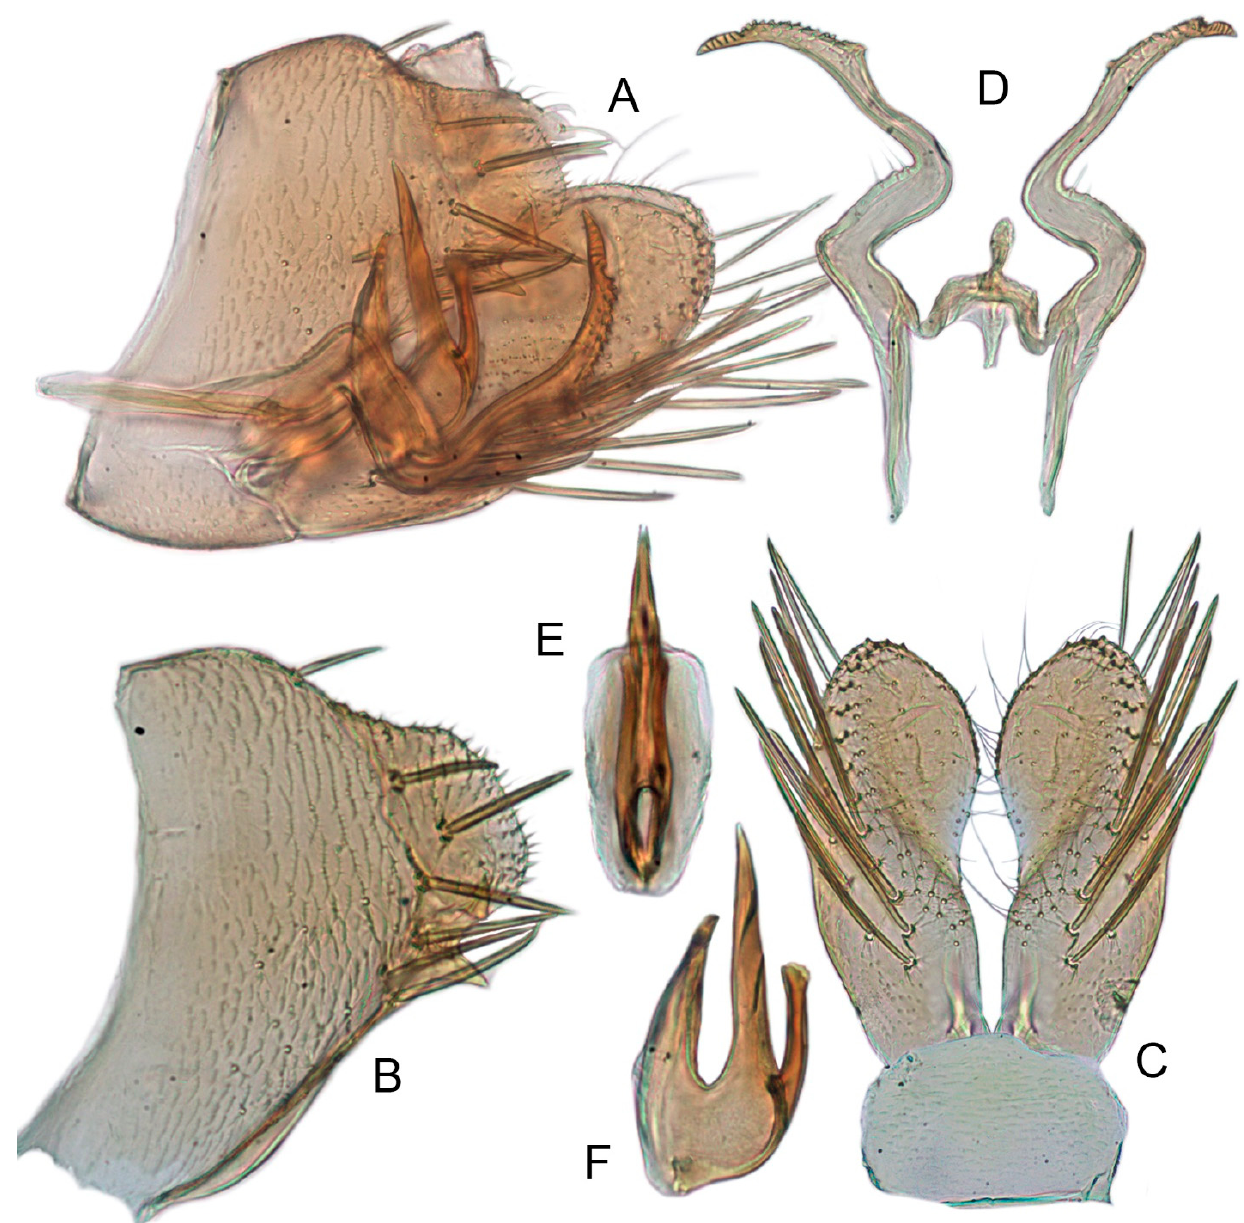
Figure 23. Xestocephalus malleus sp. nov. ( A ) Male genital capsule, lateral view; ( B ) pygofer lobe, lateral view; ( C ) subgenital plates and valve, ventral view; ( D ) style and connective, ventral view; ( E ) aedeagus, posterior view; ( F ) aedeagus, lateral view.